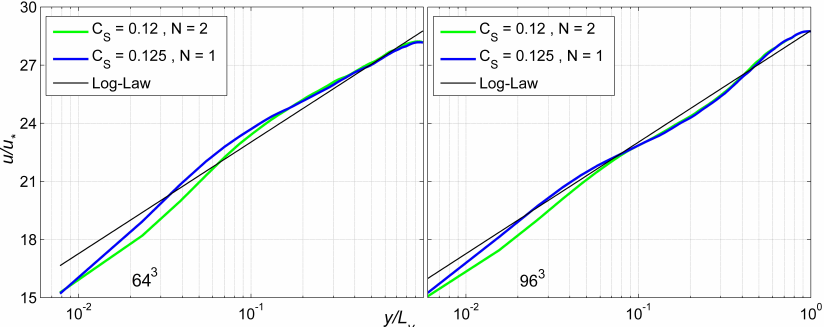
Figure 12. The average streamwise velocity with height for different grids and combinations of the Smagorinsky-Mason model. The y -axis is the ratio of the streamwise velocity to the friction velocity, u (cid:63) and x -axis is the ratio of the height and the height of the domain, L y